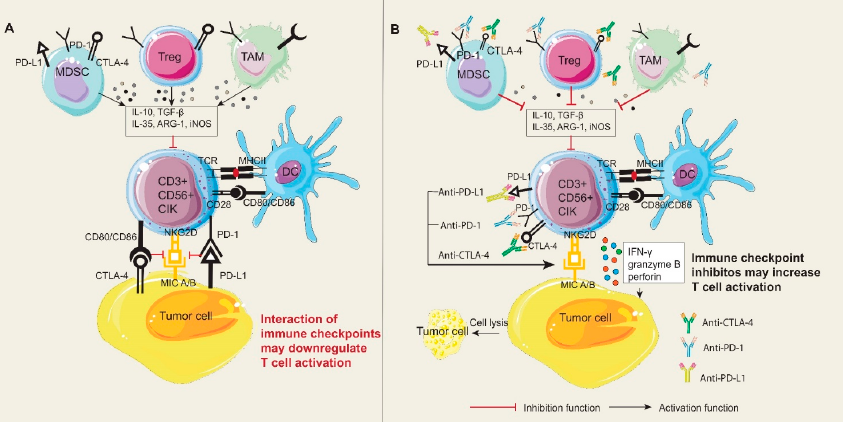
Figure 2. The potential effect of PD-1/PD-L1 interaction on CIK cells and tumor cells in the tumor microenvironment. ( A ) The interaction of immune checkpoints may downregulate T-cell activation. Upregulation of PD-1/PD-L1 or CTLA-4 on MDSCs, Tregs, and TAMs might increase the production of suppressor cytokines to restrain the function of CIK cells. DC cells capture the antigen with major histocompatibility complex (MHC) molecules, which bind to the TCR on T-cells to activate T-cells. However, the interaction of PD-1/PD-L1 or CD80/CD80 with CTLA-4 may damper the recognition of NKG2D on CIK cells with MICA/B on tumor cells and further influence the cytotoxicity of CIK cells against tumor cells. ( B ) Immune checkpoint inhibitors might amplify the cytotoxic potency of CIK cells through increasing NKG2D expression, inducing a higher CD3+CD56+ population, and reducing suppressor cytokines that are secreted by MDSCs, Tregs, and TAMs. DCs: Dendritic cells; MDSCs: Myeloid-derived suppressor cells; Tregs: Regulatory T-Cells; TAMs: Tumor-associated macrophages.